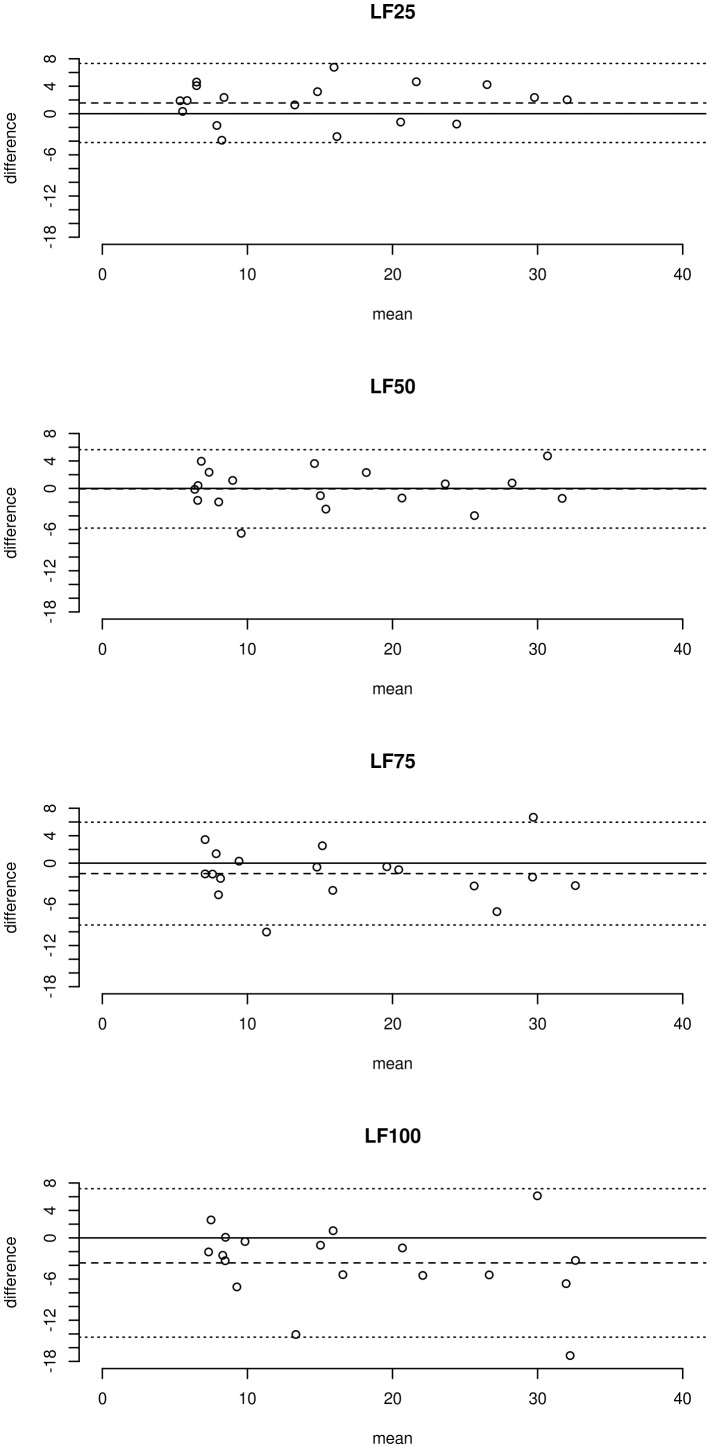
Bland-Altman plots of differences between modified Oxford baroreflex gain and transfer function moduli (y axis) and mean of the two measures (x axis).Dashed line denotes mean difference; dotted line denotes limit of agreement (range within which an individual's difference scores would fall 95% of the time).